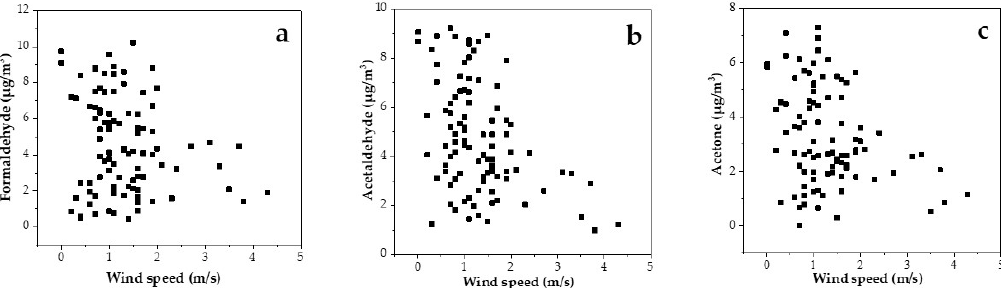
Figure 4. Correlation between the mass concentrations of formaldehyde ( a ), acetaldehyde ( b ), acetone ( c ), and wind speed at MC from 16 to 25 January 2019.